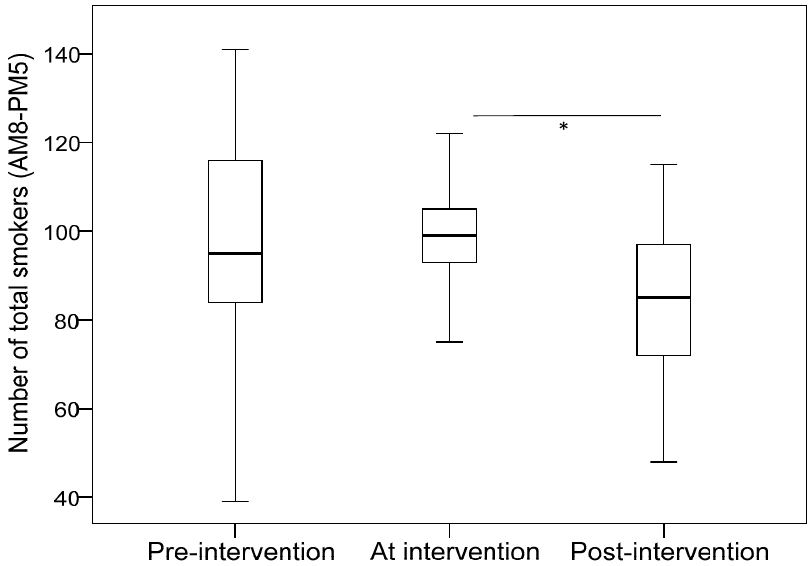
Figure 1. Number of total smokers for the whole day among the three phases of the study. * indicates p < 0.05.